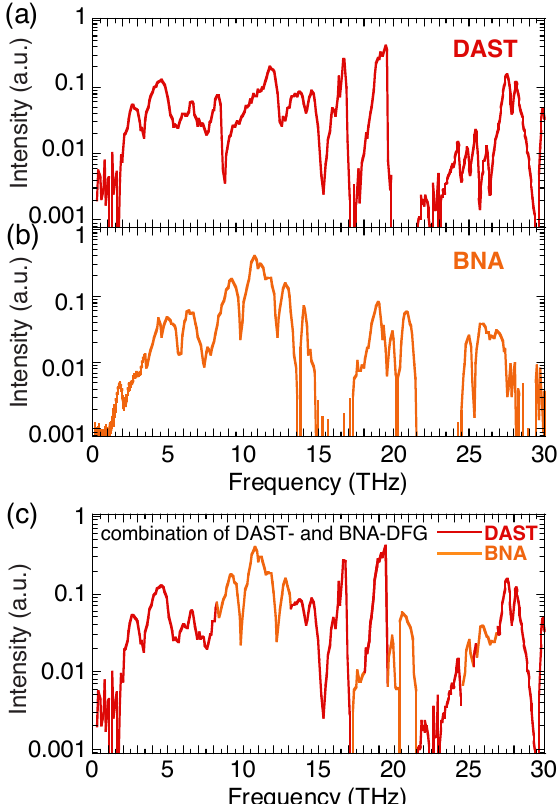
Figure 10. An example of THz-wave generation by difference-frequency generation in ( a ) DAST (0.3 mm thick) and ( b ) BNA (0.3 mm thick) using a dual-wavelength optical parametric oscillator emitting in the wavelength range 1200–1600 nm for DAST and 800–1300 nm for BNA; ( c ) an improved broadband spectrum achieved by using a different crystal at different THz frequencies. Reprinted from Ref. [106] with permission from The Optical Society